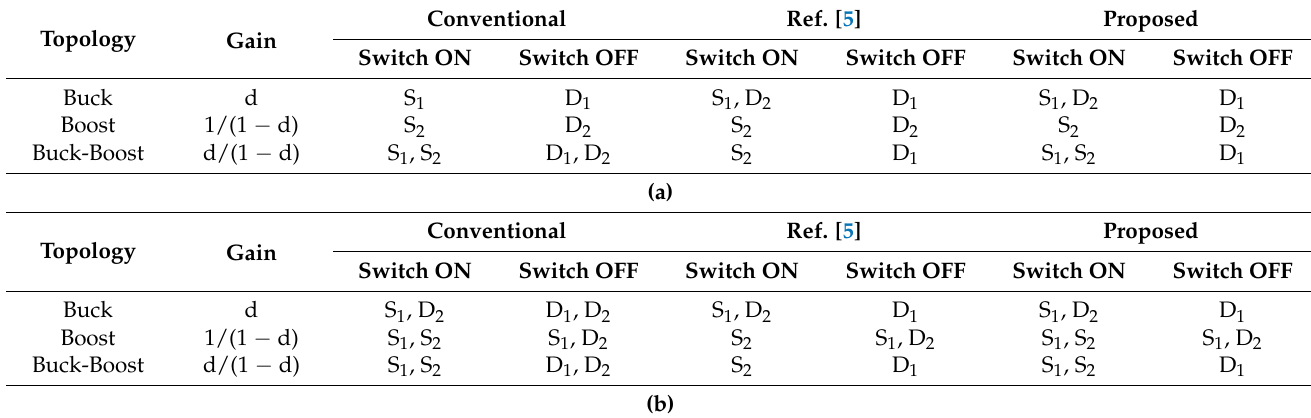
Table 6. Comparison of stress in each TSBB converter: (a) Voltage stress; (b) Current Boost Buck- Boost